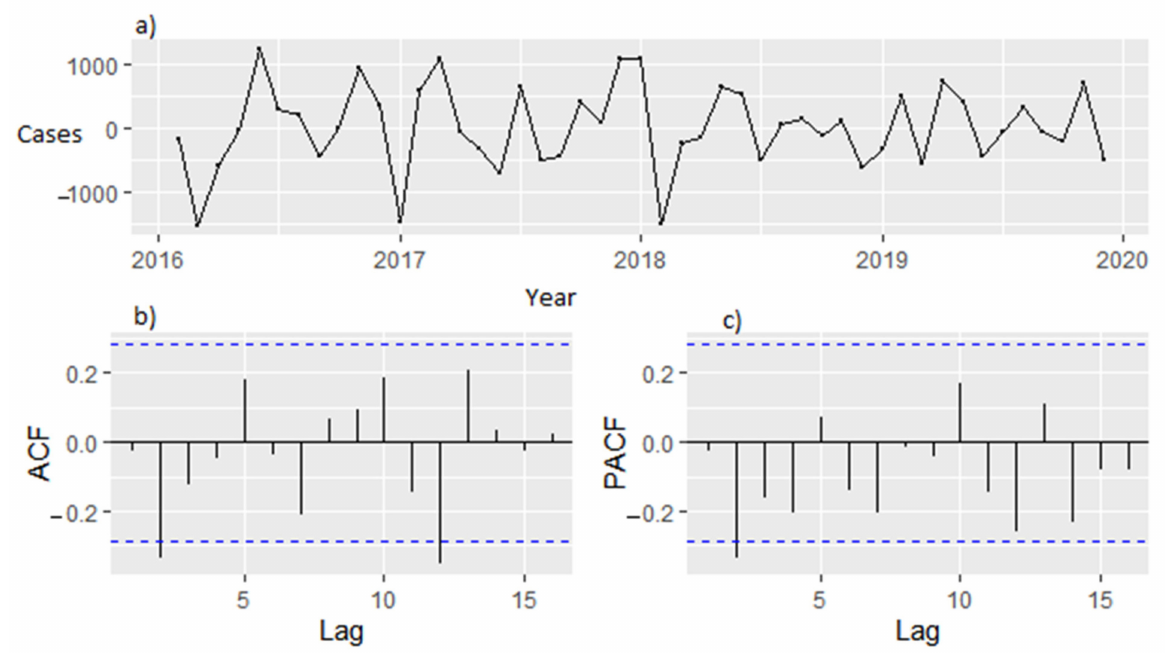
Figure 7. ( a ) Time diagram of malaria incidence after first trend and seasonal differencing. ( b ) ACF graph after trend and seasonal differencing (d = 1, D = 1) ( c ) PACF graph after trend and seasonal differencing (d = 1, D = 1).